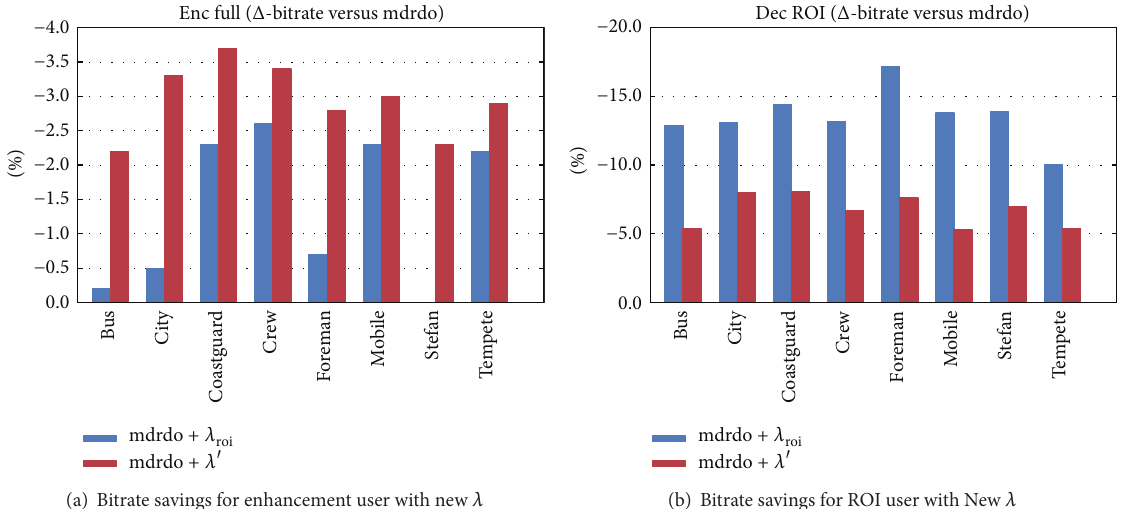
Figure 9: RD performance for quality SVC with new 𝜆 .